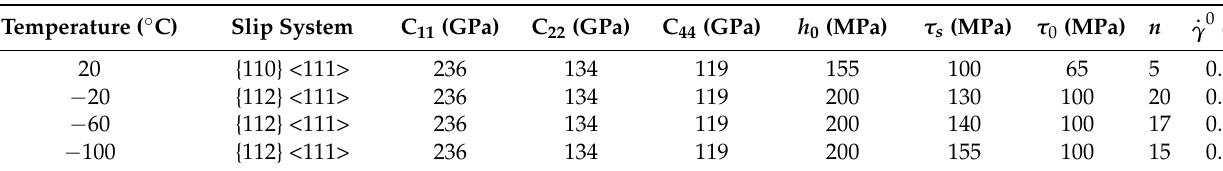
Figure 6. Comparison between tensile test and simulation results.